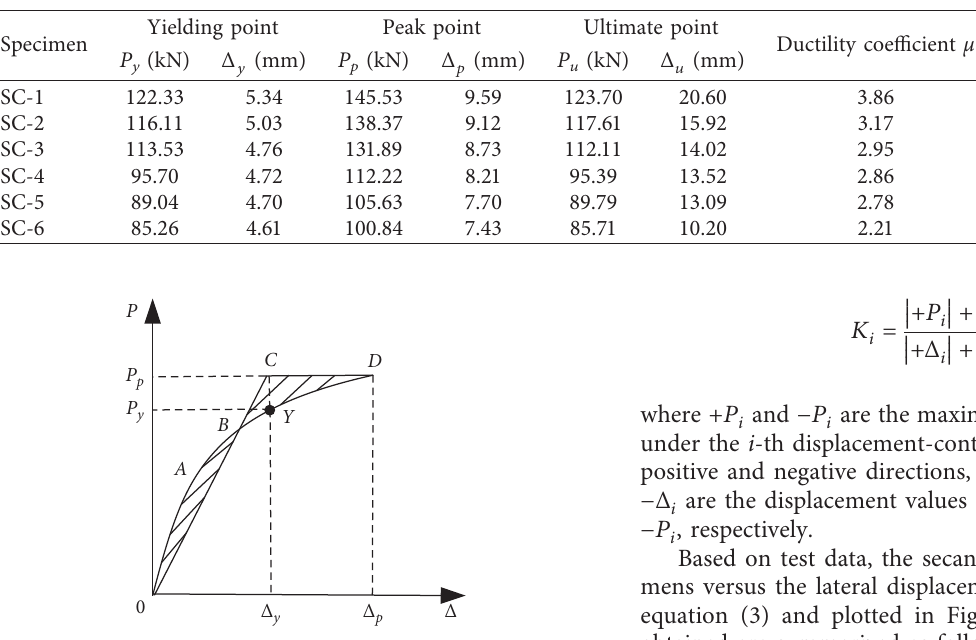
Table 6: Main seismic performance parameters of the specimens.